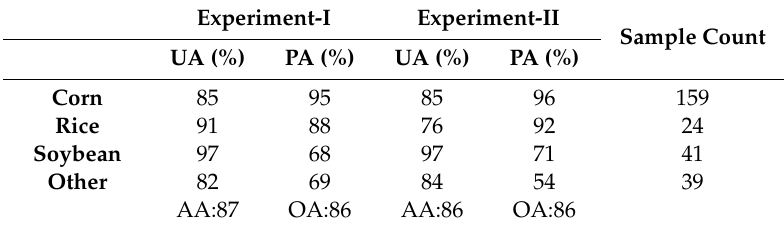
Table 5. Comparison of the accuracy among the widely used nonparallel classification methods. A refers to the method we propose, and B refers to the widely used classification methods.